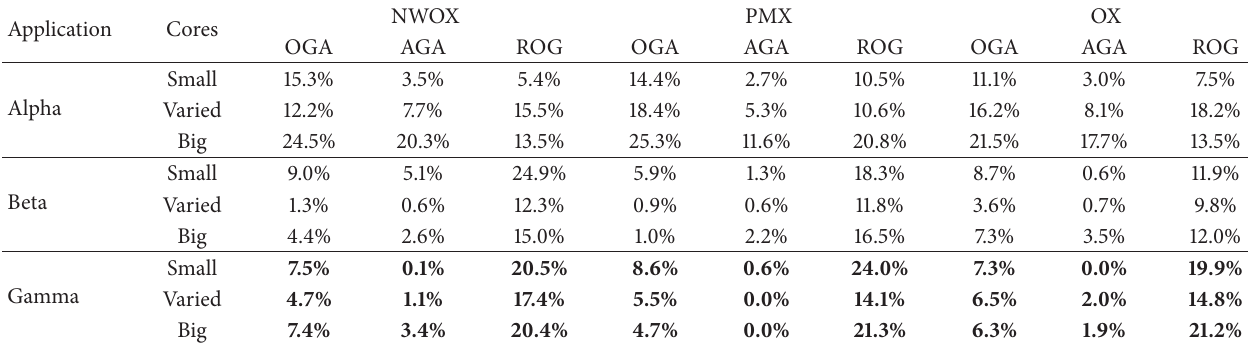
Table 4: Cost penalty from gas when compared to the minimal